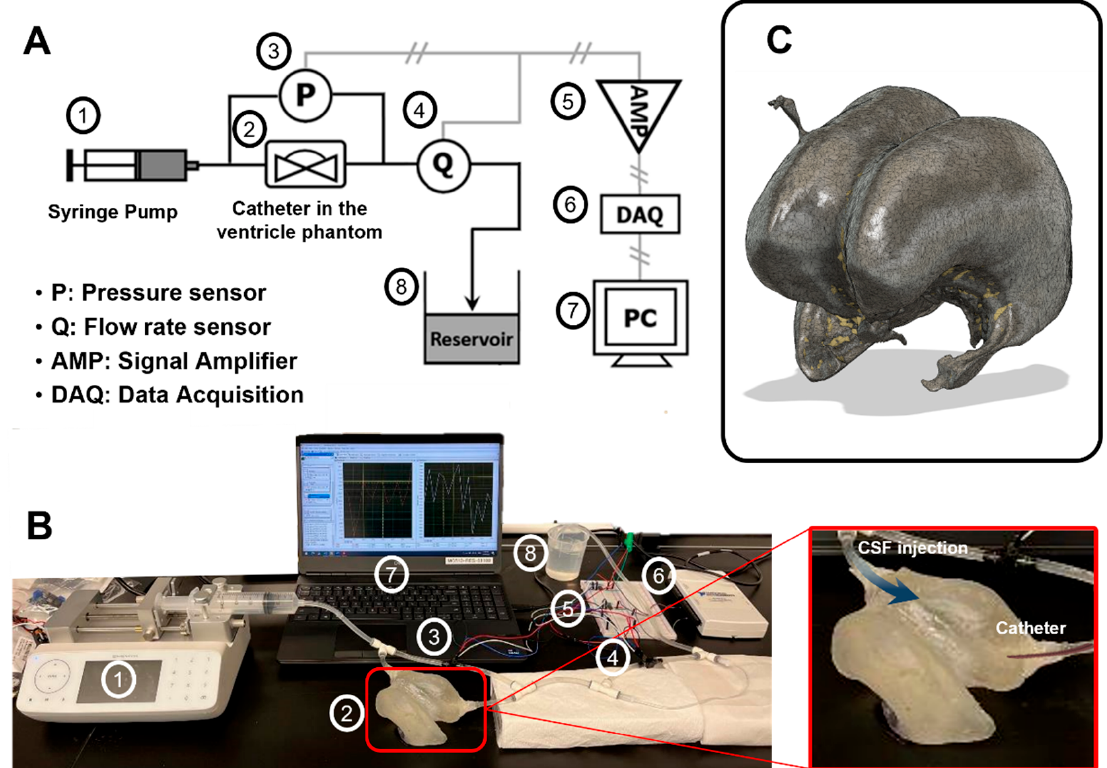
Figure 2. Catheter performance system. ( A ); Schematic of the experimental setup. A syringe pump (Fusion 200-X, Chemyx Inc) injecting artificial CSF at 0.33 mL/min (1) into the 3D-printed ventricular phantom (2). Commercial resistance pressure sensors (PX26-001DV, Omega) were used to measure pressure and flow rate with customized calibrations (3 & 4). Electric voltage signals from the sensors